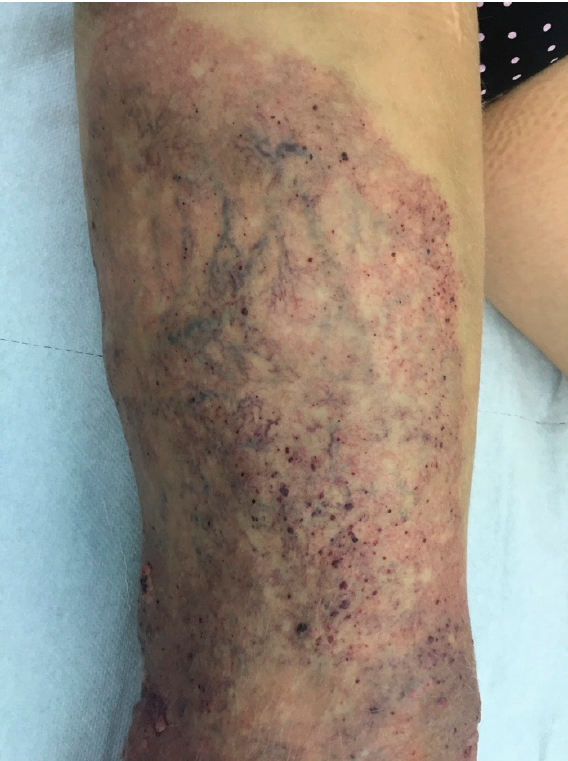
Figure 4. Final aesthetic outcome 12 months after ablation, followed by nine sessions of foam scle- rotherapy.